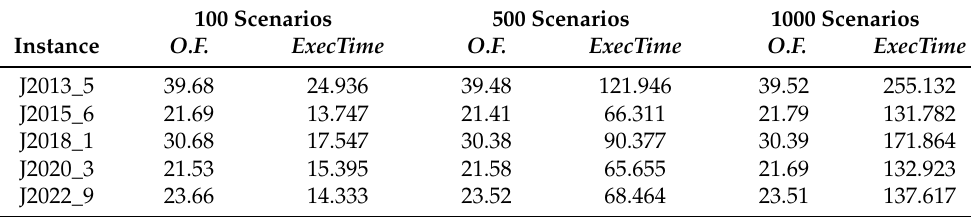
Table 12. Experiment 4 results. Different number of scenarios. Instances with 20 activities.